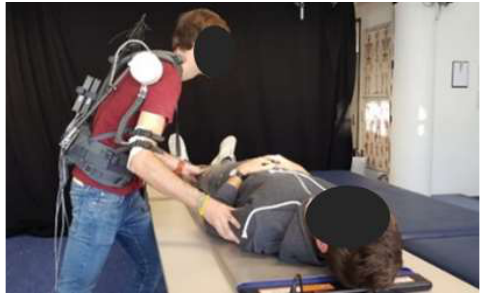
Figure 18. Preliminary laboratory tests with a prototype of the investigated exoskeleton design during the patient push scenario.